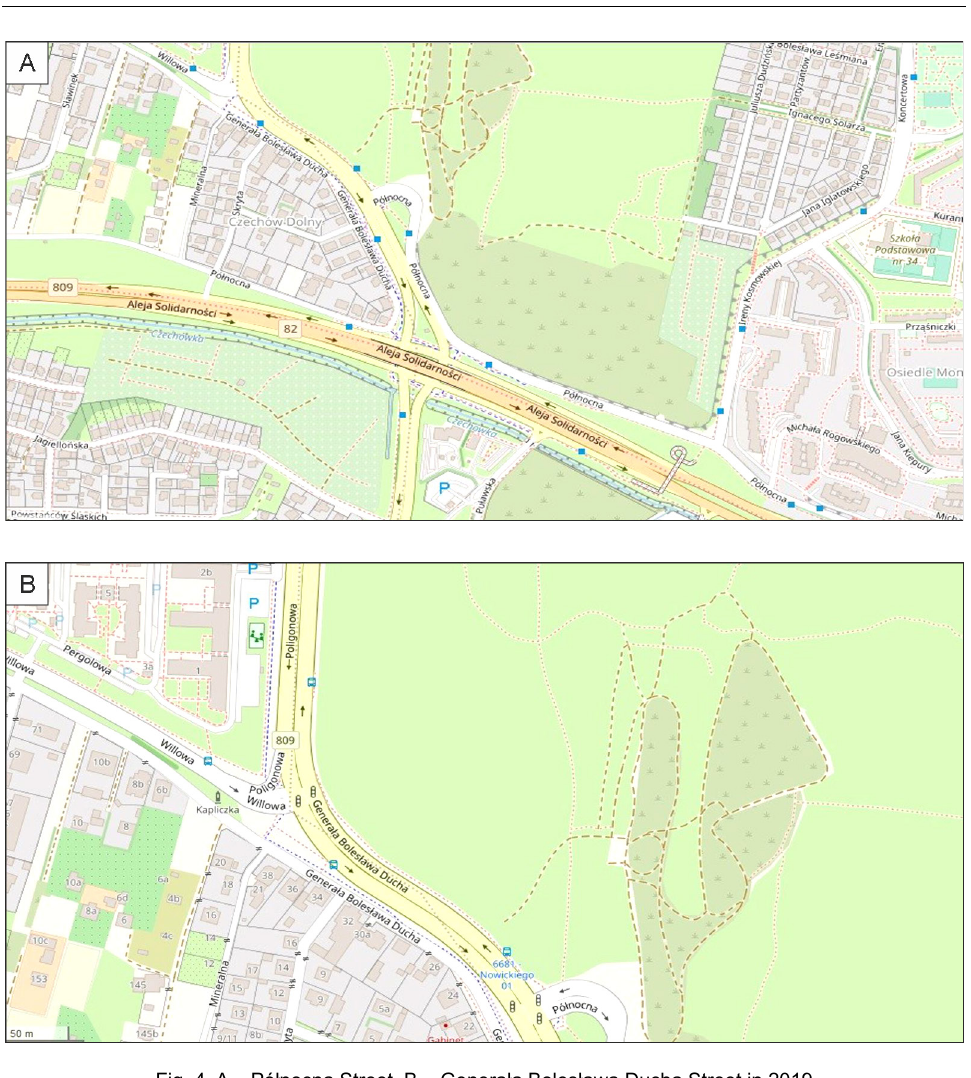
Fig. 4. A − Północna Street, B − Generała Bolesława Ducha Street in